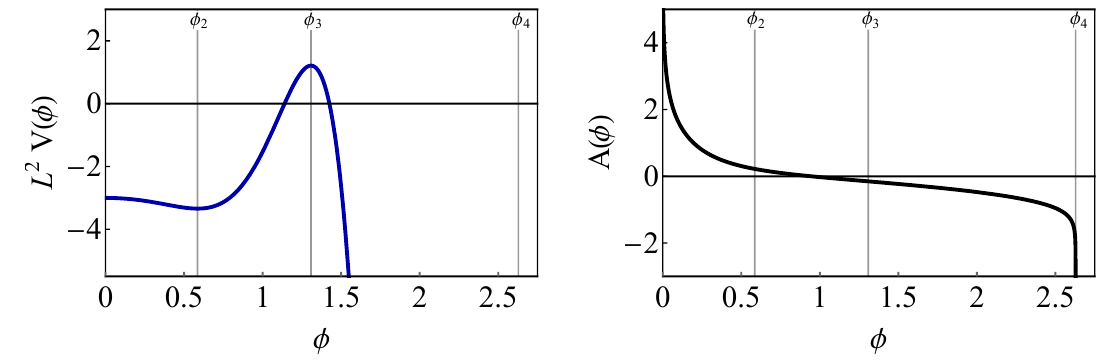
Figure 15 . Left: region of the potential with a positive maximum. Right: skipping (cid:13)ow solution for zero temperature ( h =